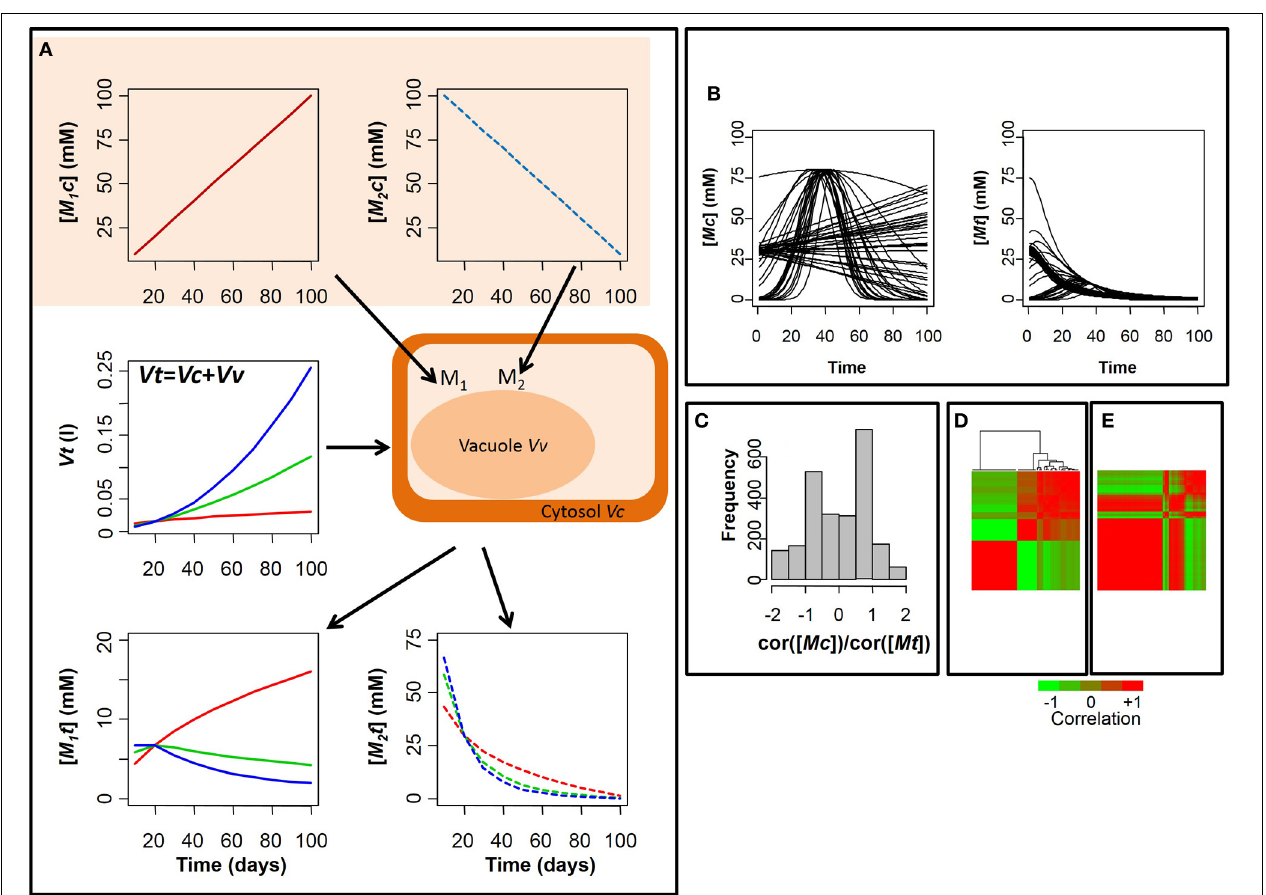
FIGURE 1 | Dynamics of the concentration of a metabolites in the cytosol and in the total tissue. (A) Dynamics of the concentration of a metabolite M in the cytosol [ Mc ] and in the total tissue [ Mt ], assuming the volume of the cytosol Vc constant. Case of an increasing/decreasing cytosolic metabolite (respectively, M 1 and M 2 ) and three growth scenarii for Vt (red, green, and blue line); (B) Simulation of seasonal variation in the concentrations of 50